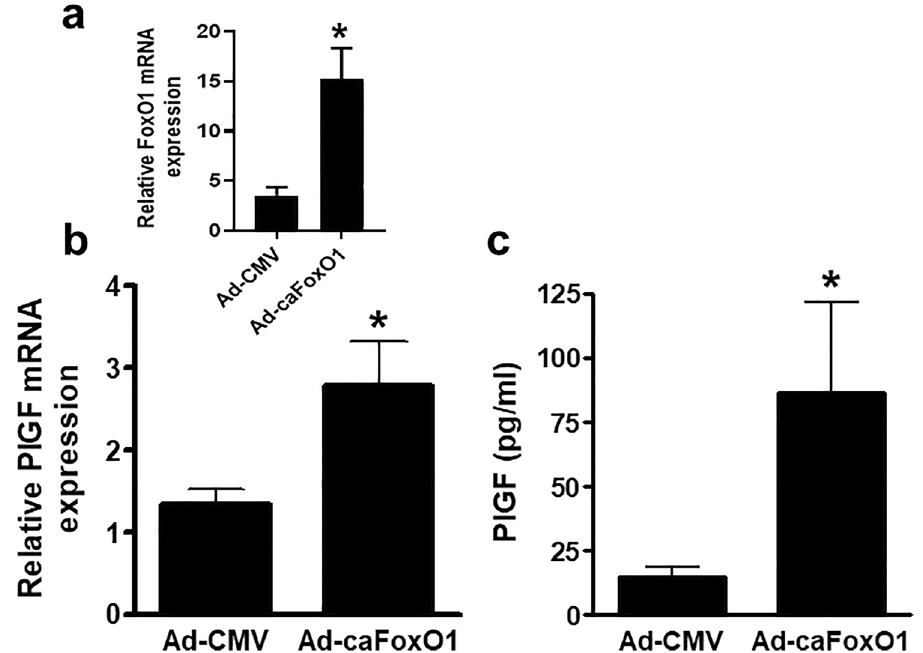
Figure 5. FOXO1 promotes PlGF expression in vivo. FVB/N mice were injected via the tail vein with 2 × 10